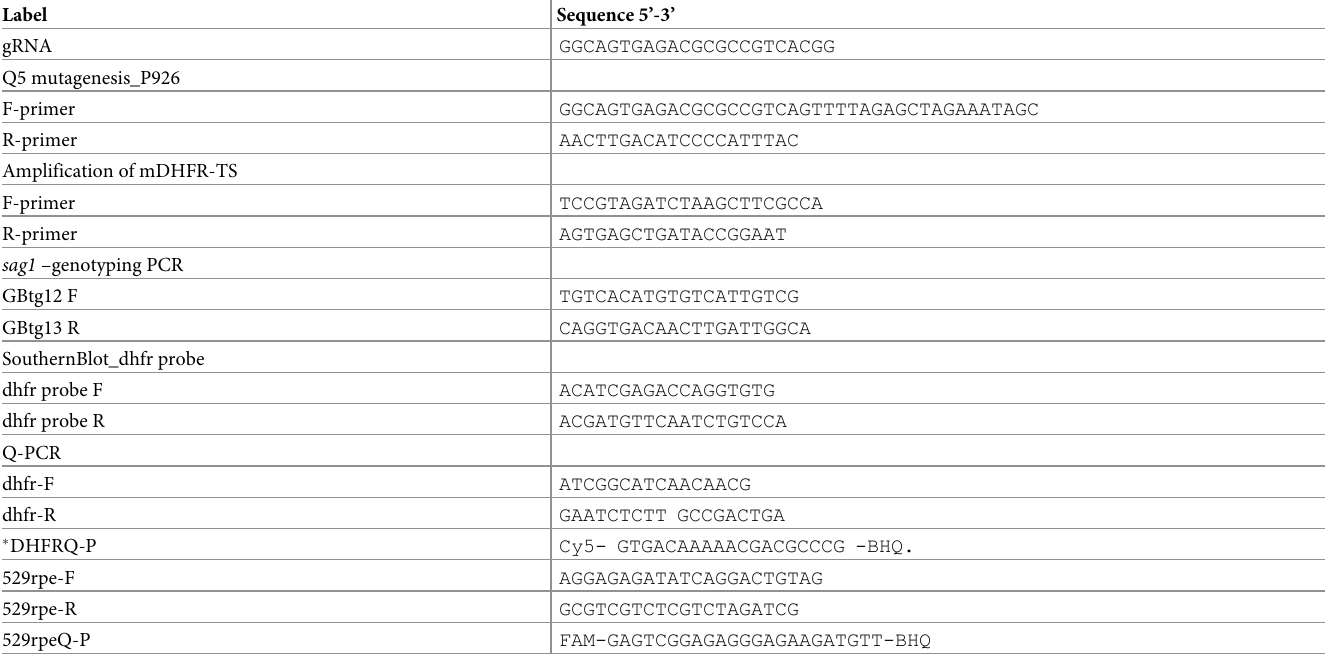
Table 1. Sequence of primers and probes used in this